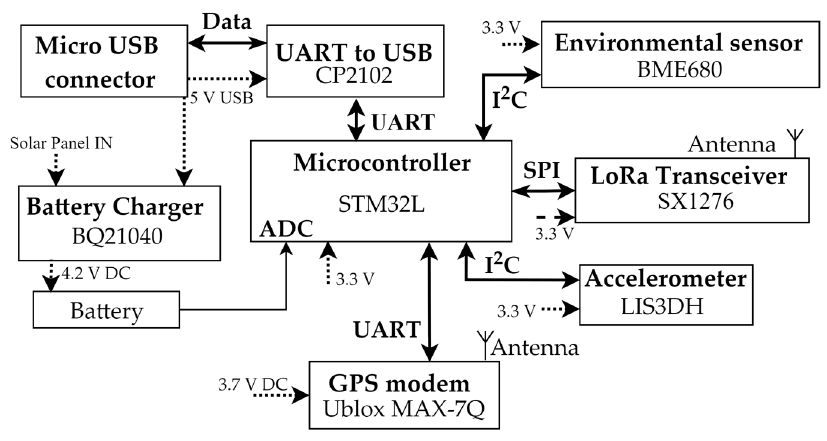
Figure 5. Structural node block scheme.